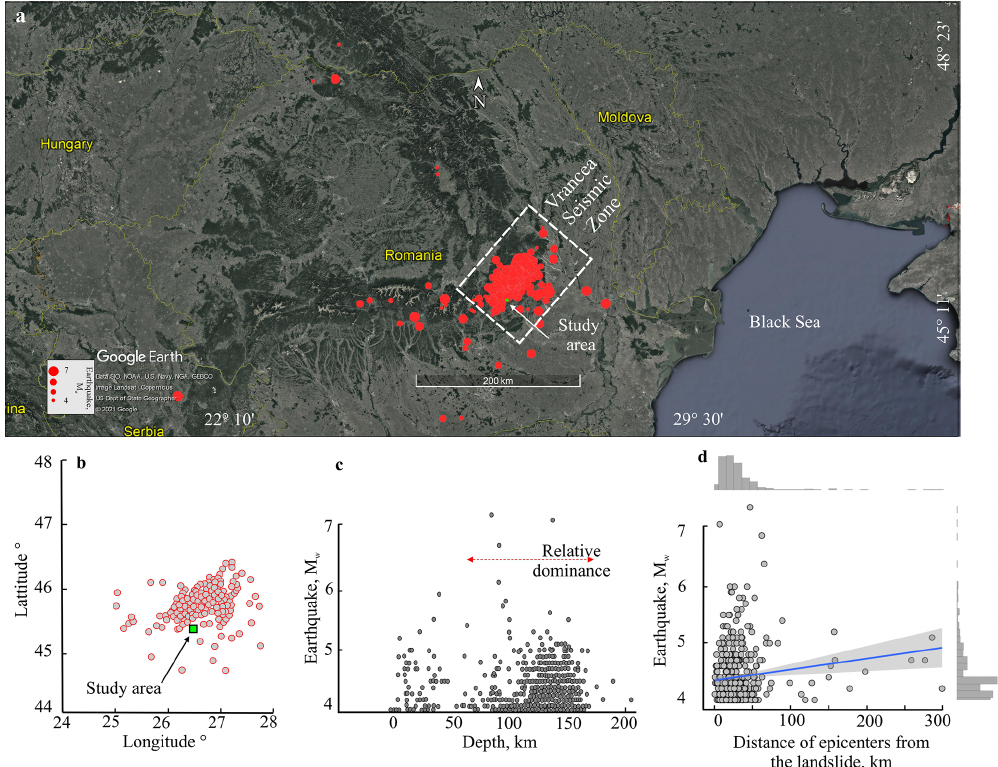
Figure 4. Earthquake pattern. (a, b) Position of study area. (c) Depth and earthquake magnitude. (d) Distance of epicenters from landslide and earthquake magnitude. The blue line (in d ) indicates linear regression, and the shaded region around it refers to the 95% confidence interval. Data source: National Institute for Earth Physics,